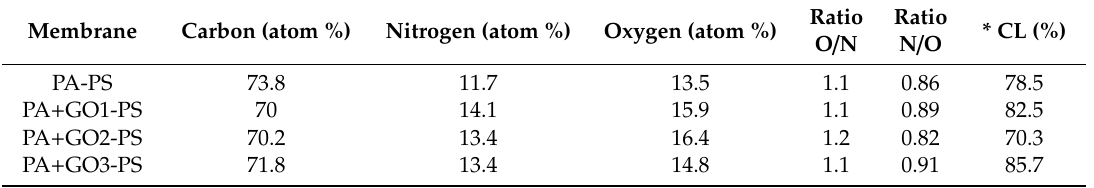
Table 4. Relative atomic concentrations and crosslinking degree of aromatic polyamide thin-film composite (TFC)